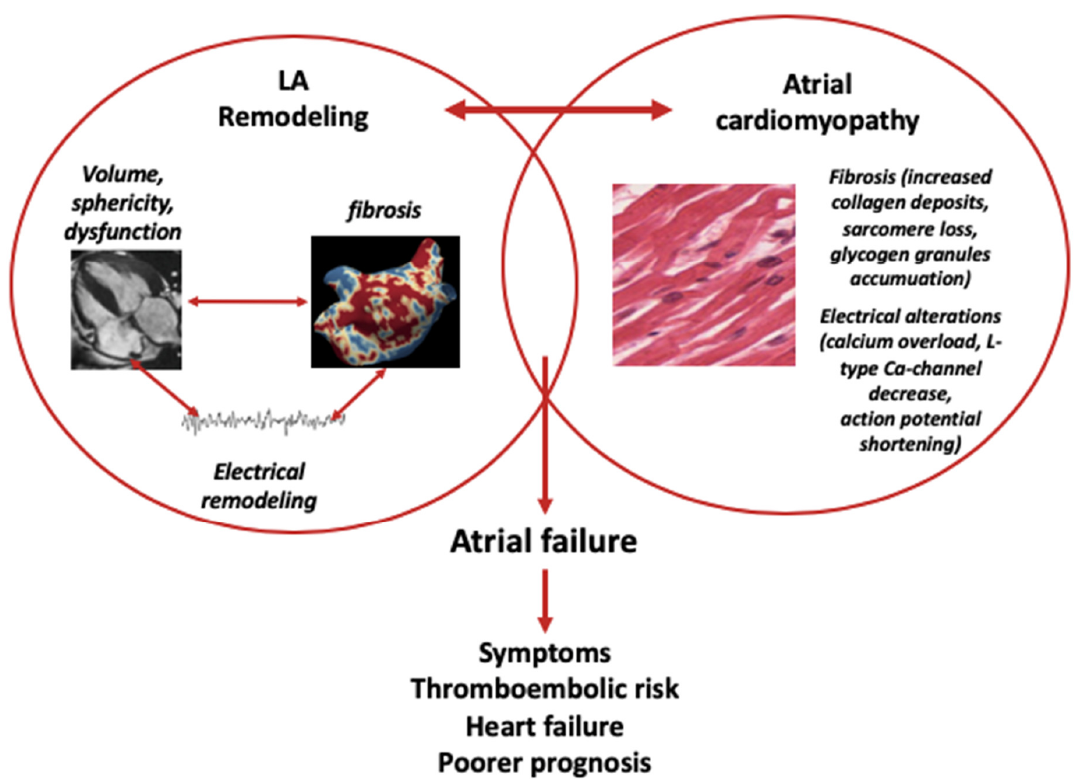
Figure 1. The bidirectional relationship between LA remodeling, atrial cardiomyopathy and atrial failure.